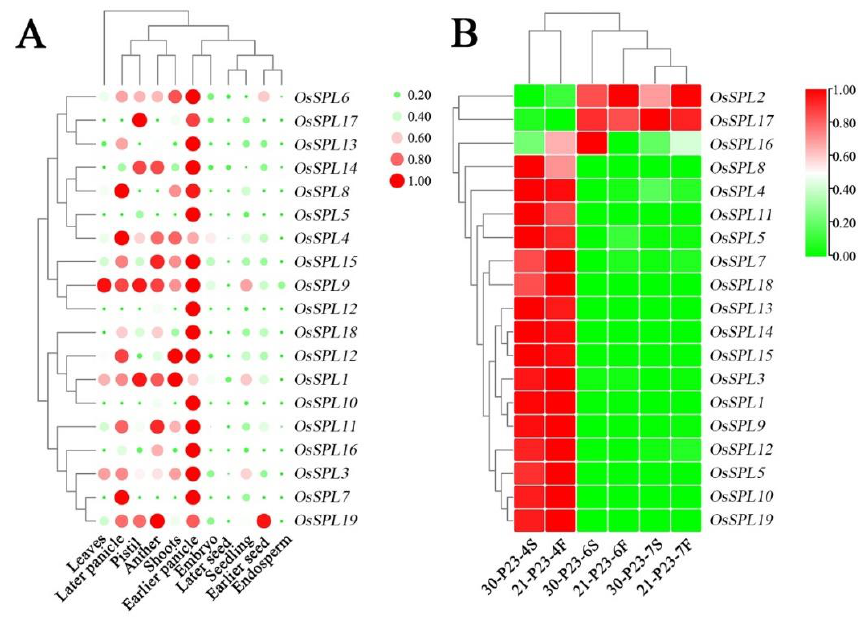
Figure 2. The gene expression analysis of OsSPL family in rice tissue. ( A ) Expression profiles of SPL gene family in different periods and tissues of rice. ( B ) Expression profiles of SPL gene family in young spikelets of fertility differential plants treated with different temperatures. 30/21. Treated at 30 °C or 21 °C. P23/P28. PA2364S/PA2864S. 4S/4F. The 4th stage sterile or fertile plants. For each treatment, the RNA-seq results show the average of three replicates.